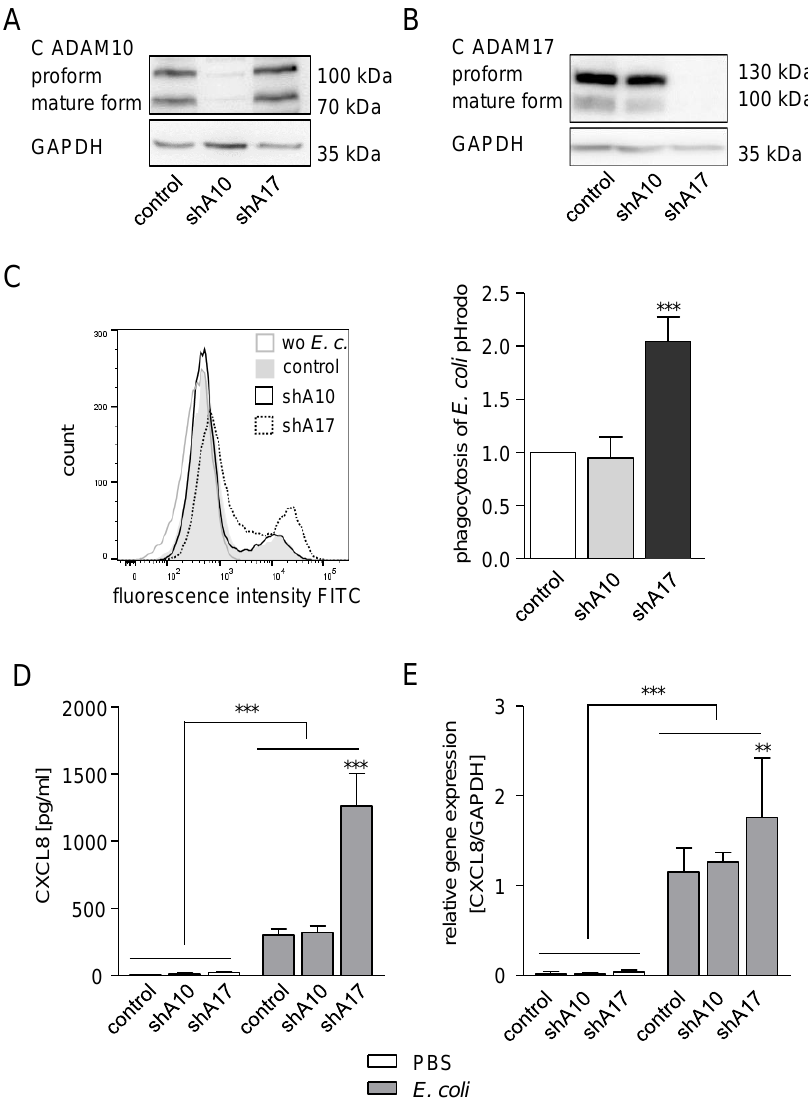
Figure 4. Knockdown of ADAM17 enhances phagocytosis of E. coli and CXCL8 release, ( A , B ) THP-1 cells were transduced with lentivirus encoding control – shRNA (Short hairpin RNA) (control), ADAM10 – shRNA (shA10) or ADAM17 – shRNA (shA17) and analysed for ADAM10 ( A ) and ADAM17 ( B ) knockdown by Western blot. GAPDH served as loading control. ( C , E ) THP-1 cells transduced as described in ( A , B ) were exposed to E. coli pHrodo green and assayed for phagocytosis by flow cytometry ( C ), CXCL8 release by ELISA ( D ) and CXCL8 mRNA expression by RT-qPCR ( E ). Quantitative data were calculated in relation to that of the indicated control. Data are shown as mean and SD or as one representative of at least three independent experiments ( C ) n = 6; ( D , E ) n = 3. Significant differences compared to the respective control are indicated as asterisks (* p < 0.05, ** p < 0.01, *** p < 0.001) and additional comparisons are specified by bars.